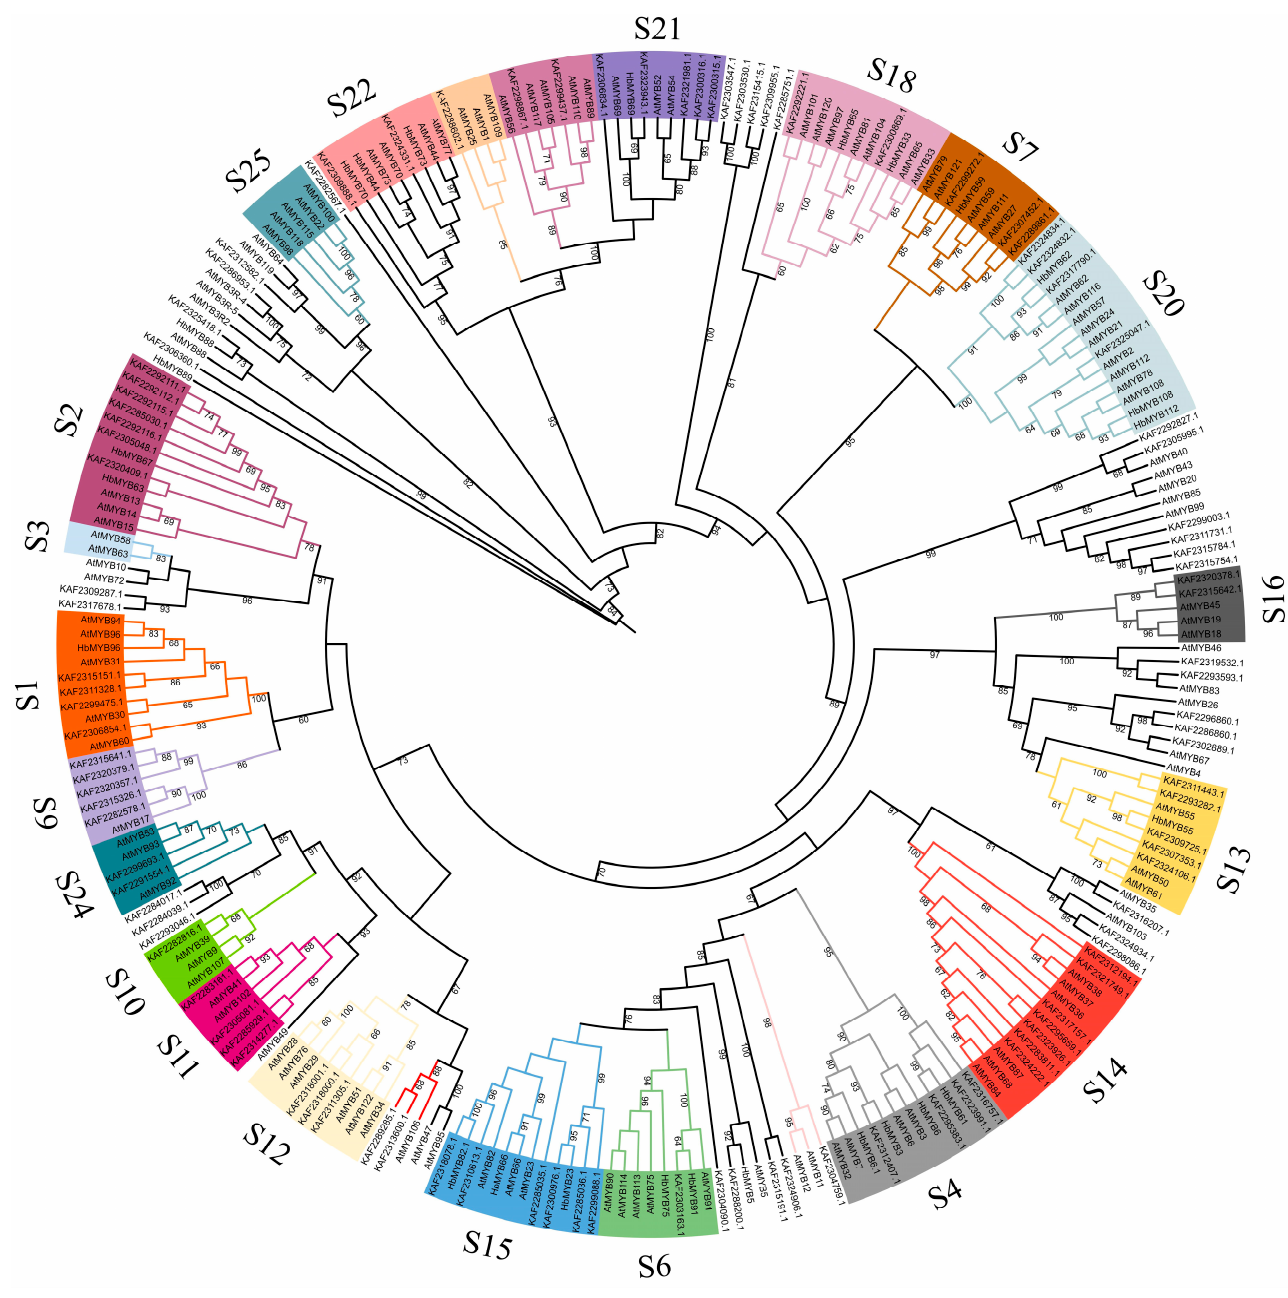
Figure 4. Phylogenetic analysis of HbR2R3-MYBs and AtMYBs. The protein sequence of HbR2R3- MYBs and AtMYBs were aligned by ClustalW and the unrooted phylogenetic tree constructed by the neighbor-joining (NJ) method with 1000 bootstrap replicates.